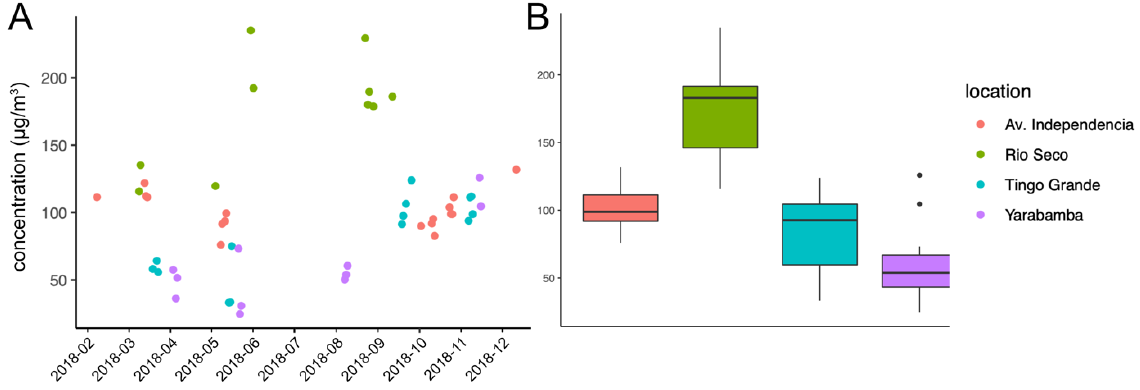
Figure 2. PM 10 concentrations during the sampling period at all the sites. ( A ) Time series of observed PM 10 concentrations in this study; ( B ) box plot of PM 10 concentrations at each site.